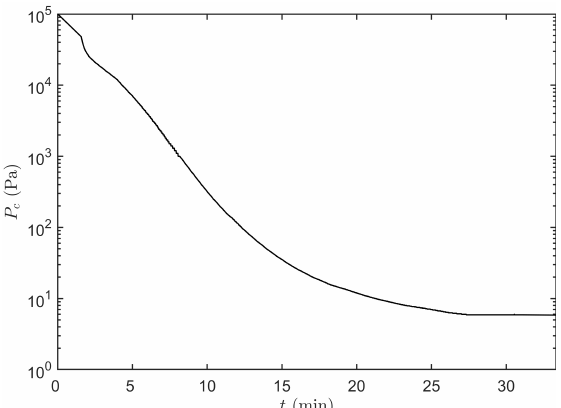
Figure 5. Trajectory of the chamber pressure P c in function of time t which is followed during the primary drying initialization phase.